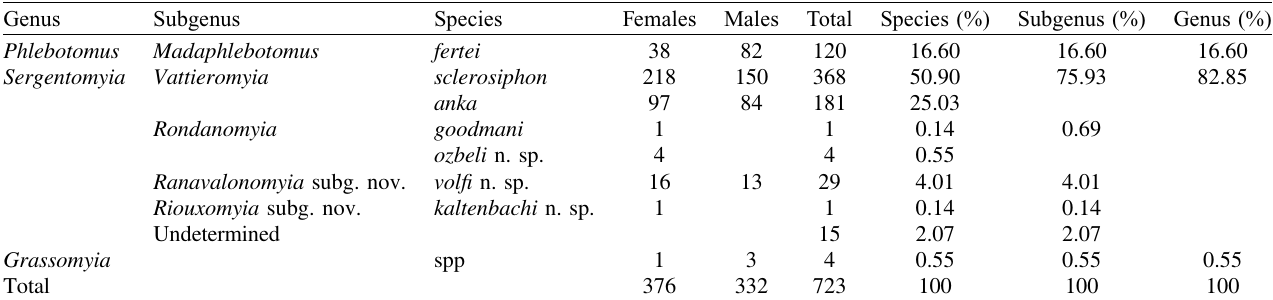
Table 1. Distribution of sand fl ies collected in the Ankarana tsingy.